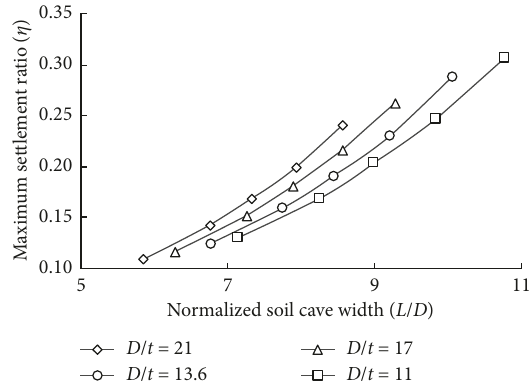
Figure 8: Influence of soil cave width on the maximum settlement